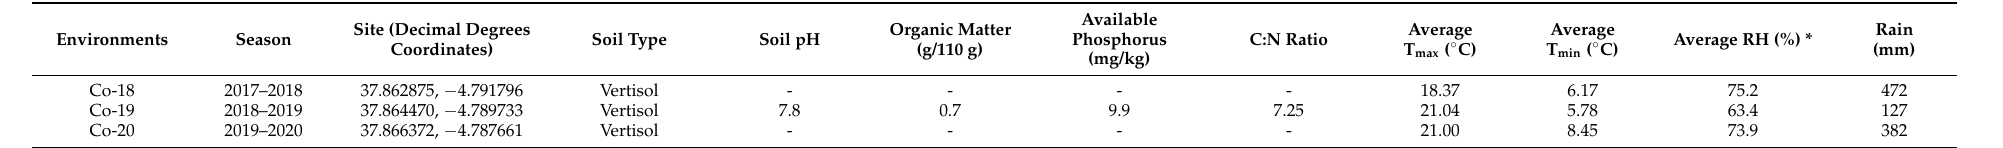
Table 1. Description of the environments of the trials for the multi-environment study during the crop cycle from December to May.